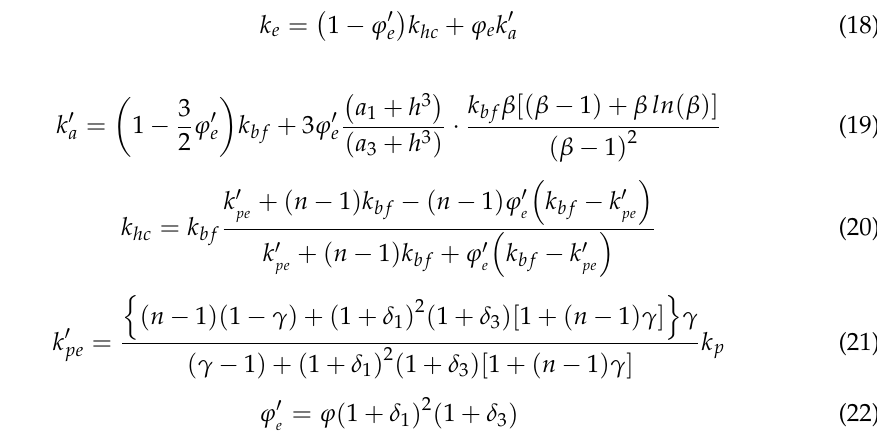
concentration ( φ e ) (particle size plus the thickness of the layer with which they are coated).